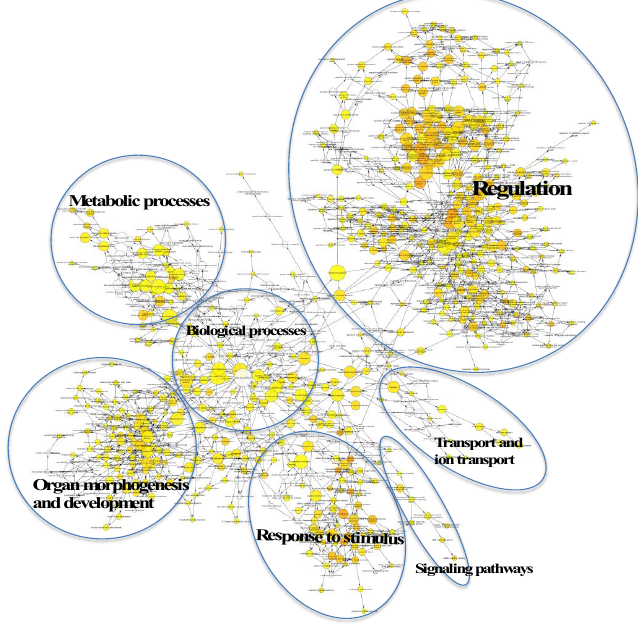
Figure 3. Visualisation of the biological processes (BPs) resulting from the analysis of target genes regulated by hsa-miR-205 associated with HaCaT-derived EVs using Cytoscape (Version 3.2.1).